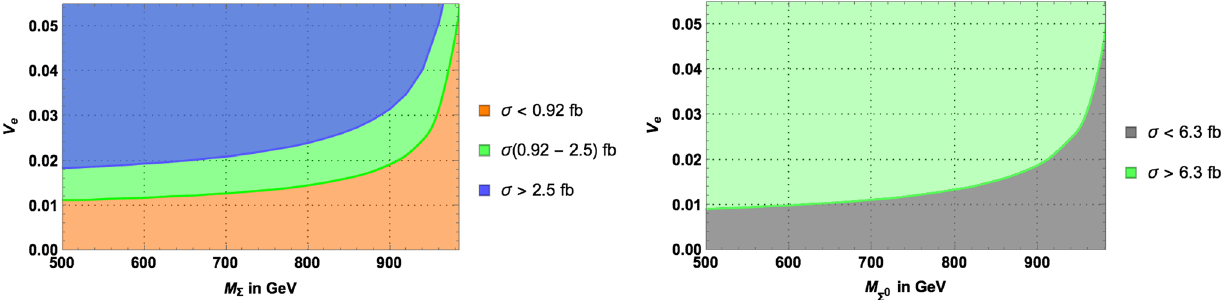
Fig. 7 Regions of the M (cid:2) – V e plane with different ranges of cross sec- tion values for single production at 1 TeV centre-of-mass energy as indicated. The figure on the left corresponds to (cid:2) ± e ∓ production, and